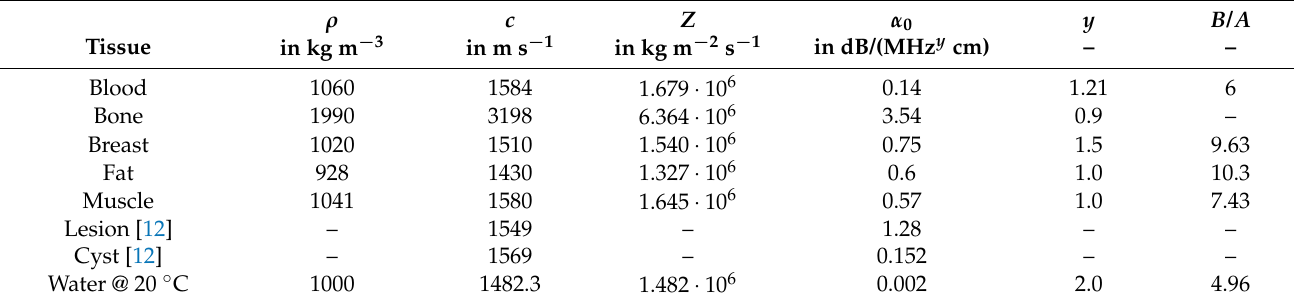
Table 1. Physical properties of different biological tissues, where ρ , is the mass density, c , the speed of sound and Z , the acoustic impedance, α 0 , the power law prefactor, y , the power law exponent, and B / A , the nonlinearity parameter [4] (except for lesion and